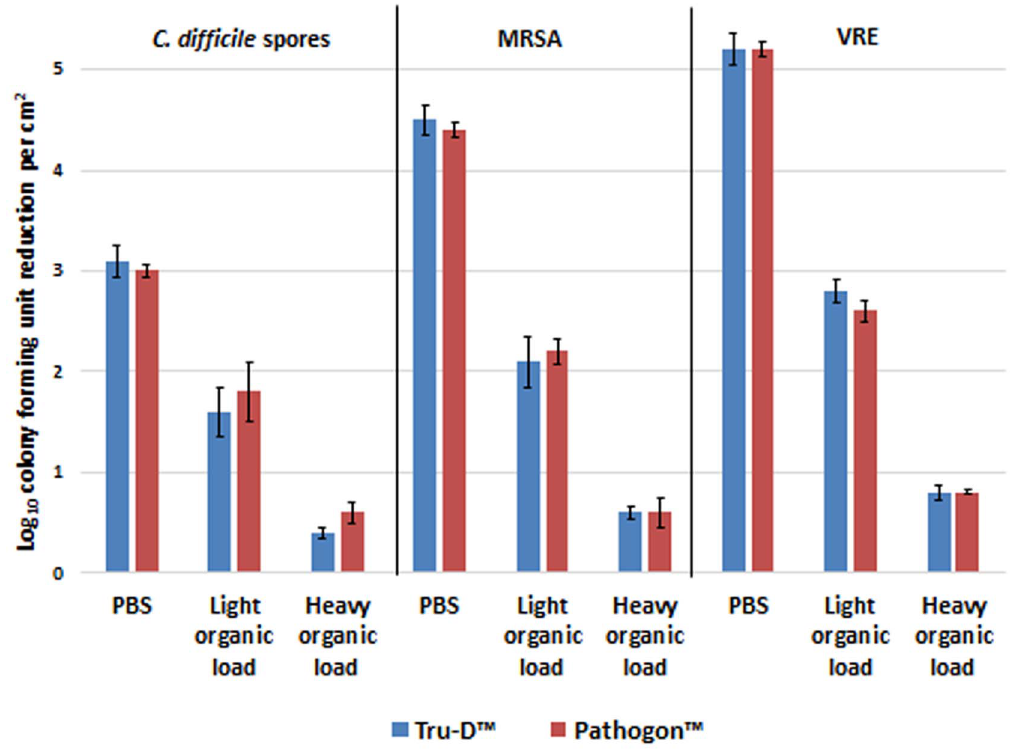
Figure 3. The effect of organic load on the efficacy of the UV-C devices. The log 10 CFU reduction/cm 2 of C. difficile spores, MRSA, and VRE suspended in phosphate-buffered saline (PBS), light organic load (5% fetal calf serum), or heavy organic load (5% fetal calf serum, 5% tryptone). Carriers contained 6 log 10 CFU of each pathogen. The carriers were irradiated for 41 minutes at a distance of 4 feet from the Tru-D or Pathogon device. The means of the data from experiments conducted in triplicate are presented. Error bars indicate standard error.